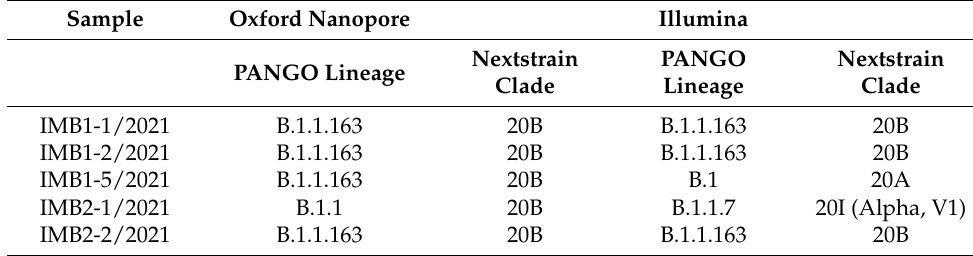
Table 2. Comparison of the PANGO lineage and GISAID clade assignment for consensus sequences produced with Oxford Nanopore Technologies and Illumina.